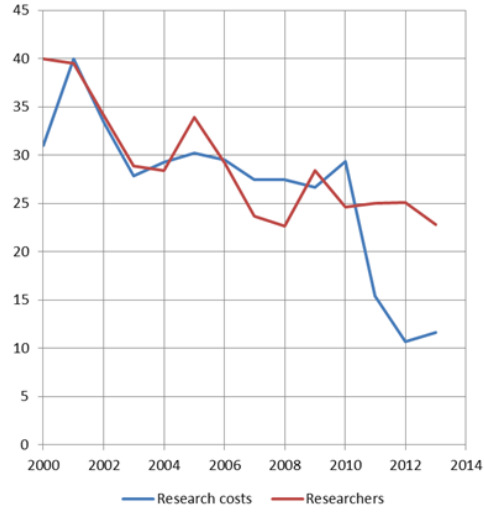
Figure 3: Share of resources allocated to research within SKB